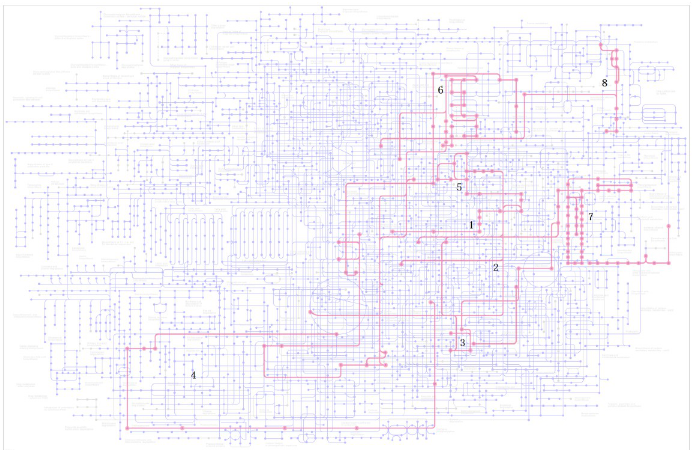
Fig 12. The KEGG metabolism pathway map. 1, Tryptophan metabolism 2, Tyrosine metabolism 3, Glutathione metabolism 4, Phenylalanine metabolism 5, Phenylalanine, tyrosine and tryptophan biosynthesis 6, Pyrimidine metabolism chlorophyll metabolism 7, Porphyrin and chlorophyll metabolism 8, Riboflavin metabolism.